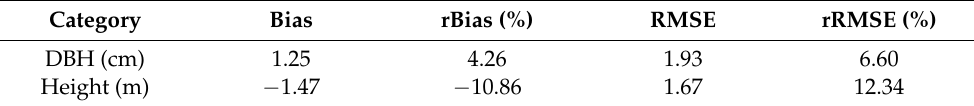
cm respectively. The DBH deviation of 70.5% of all sample trees was less than 1.93 cm. 68.2% of all sample trees was less than 1.67 m. Table 1. Comparison of DBH and tree height accuracy using AdQSM and forest